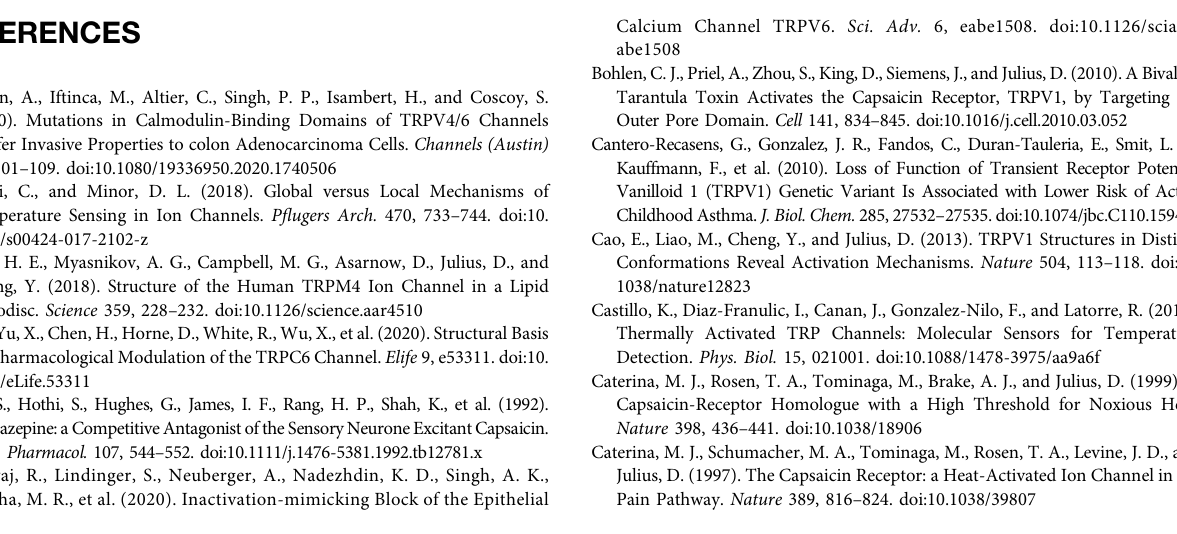
TRPV1 (B) (PDB ID: 5IS0), cis22a bound to TRPV6 (C) (PDB ID: 7K4B), and econazole bound to TRPV5 (D) (PDB ID: 6B5V). Residues that belong to a speci fi c structural domain are grouped in highlighted islands (green) and labeled. The analysis was performed using LigPlot + software (https://www.ebi.ac.uk/thornton- srv/software/LigPlus/). Supplementary Figure S3 | LigPlot + analysis for the pore site. LigPlot + diagrams for RR bound to the selectivity fi lter site (A) (PDB ID: 7S8B) and cis22a bound to the intracellular pore entry site (B) (PDB ID: 7K4B) in TRPV6. Residues that belong to a speci fi c structural domain are grouped in highlighted islands (green) and labeled. The analysis was performed using LigPlot + software (https://www.ebi.ac.uk/ thornton-srv/software/LigPlus/). SupplementaryFigureS4| LigPlot + analysisfortheS4-S5sites.LigPlot + diagrams for piperlongumine bound tothe deep S4-S5 site inTRPV2 (A) (PDB ID: 6WKN) and econazole bound to the shallow S4-S5 site in TRPV6 (B) (PDB ID: 7S8C). Residues that belong to a speci fi c structural domain are grouped in highlighted islands (green) and labeled. The analysis was performed using LigPlot + software (https://www.ebi. ac.uk/thornton-srv/software/LigPlus/). Supplementary FigureS5 | LigPlot + analysisfor theportalsites. LigPlot + diagrams for cannabidiol bound to the deep portal site in TRPV2 (A) (PDB ID: 6U8A) and ZINC17988990 bound to the shallow portal site in TRPV5 (B) (PDB ID: 6PBE). Residues that belong to a speci fi c structural domain are grouped in highlighted islands (green) and labeled. The analysis was performed using the LigPlot + software (https://www.ebi.ac.uk/thornton-srv/software/LigPlus/). SupplementaryFigureS6| LigPlot + analysisfortheS1-S4sites.LigPlot + diagrams for 2-APB bound to the S1-S4 top site in TRPV3 (A) (PDB ID: 6DVZ), 2-APB-Br bound to the S1-S4 base site in TRPV6 (B) (PDB ID: 6D7V), osthole bound to the S1-S4basesiteinTRPV3 (C) (PDBID:7RAS),andZINC17988990boundtotheS1- S4 base site in TRPV5 (D) (PDB ID: 6PBE). Residues that belong to a speci fi c structural domain are grouped in highlighted islands (green) and labeled. The analysis was performed using LigPlot + software (https://www.ebi.ac.uk/thornton- srv/software/LigPlus/). Supplementary Figure S7 | LigPlot + analysis for the ARD – TMD interface sites. LigPlot + diagrams for 2-APB bound to the ARD-TMD linker site in TRPV3 (A) (PDB ID: 6DVZ), osthole bound to the ARD-TMD linker site in TRPV3 (B) (PDB ID: 7RAS), and PIP 2 bound to the S2-S3 site in TRPV5 (C) (PDB ID: 6DMU). Residues that belong to a speci fi c structural domain are grouped in highlighted islands (green) and labeled. The analysis was performed using LigPlot + software (https://www.ebi.ac. uk/thornton-srv/software/LigPlus/). Supplementary Figure S8 | LigPlot + analysis for the ARD site. LigPlot + diagrams for ATP bound to TRPV1 (A) (PDB ID: 2PNN) and desthiobiotin bound to TRPV6 (B) (PDB ID: 5WO9). Residues that belong to a speci fi c structural domain are grouped in highlighted islands (green) and labeled. The analysis was performed using LigPlot + software (https://www.ebi.ac.uk/